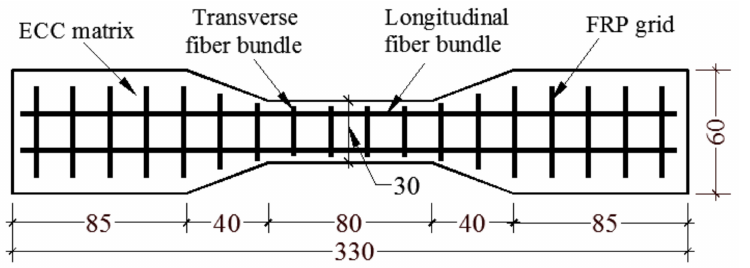
Figure 1. Schematic design of FRP grid-reinforced ECC uniaxial tensile